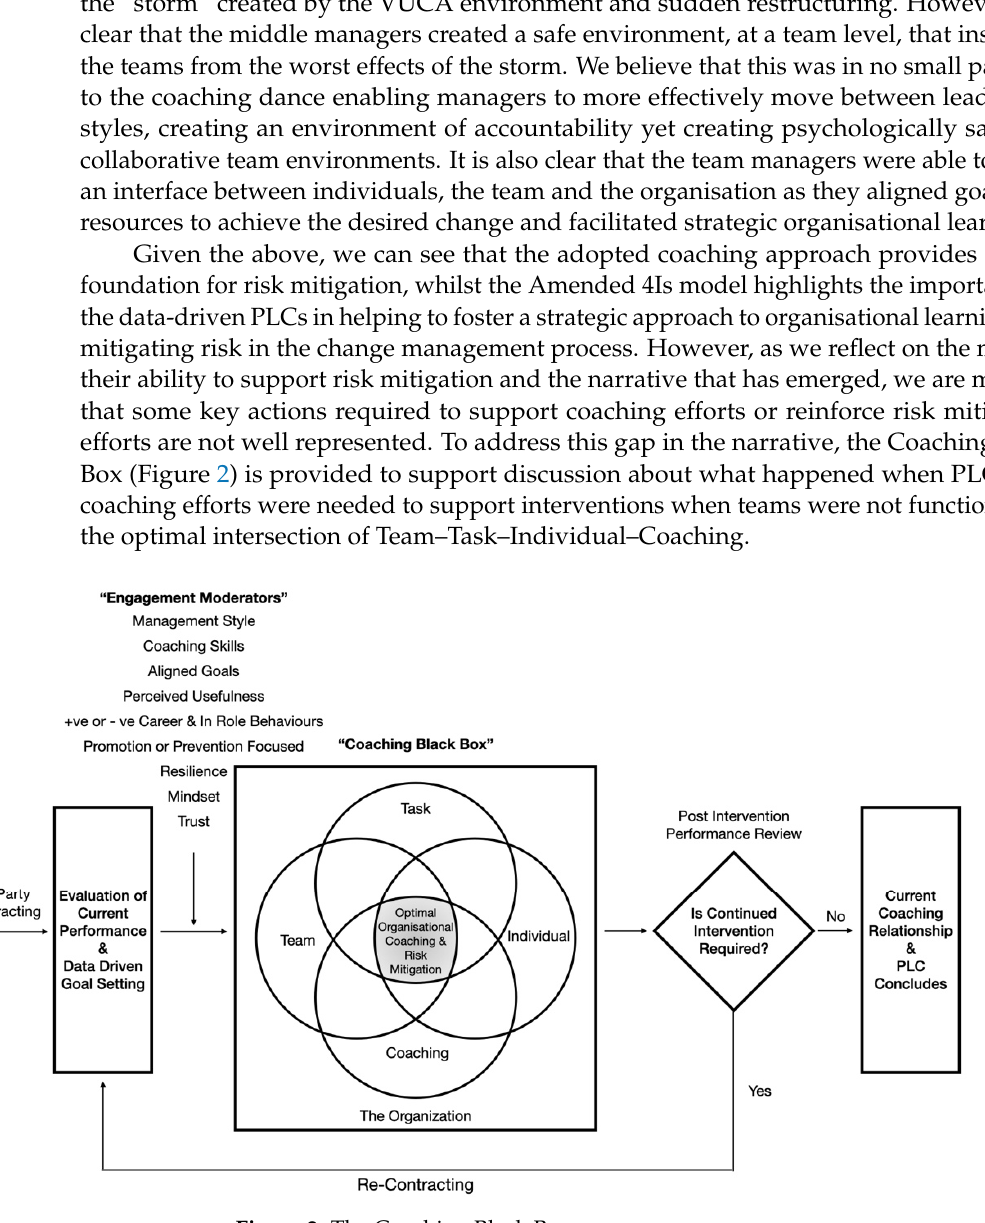
Figure 2. The Coaching Black Box.